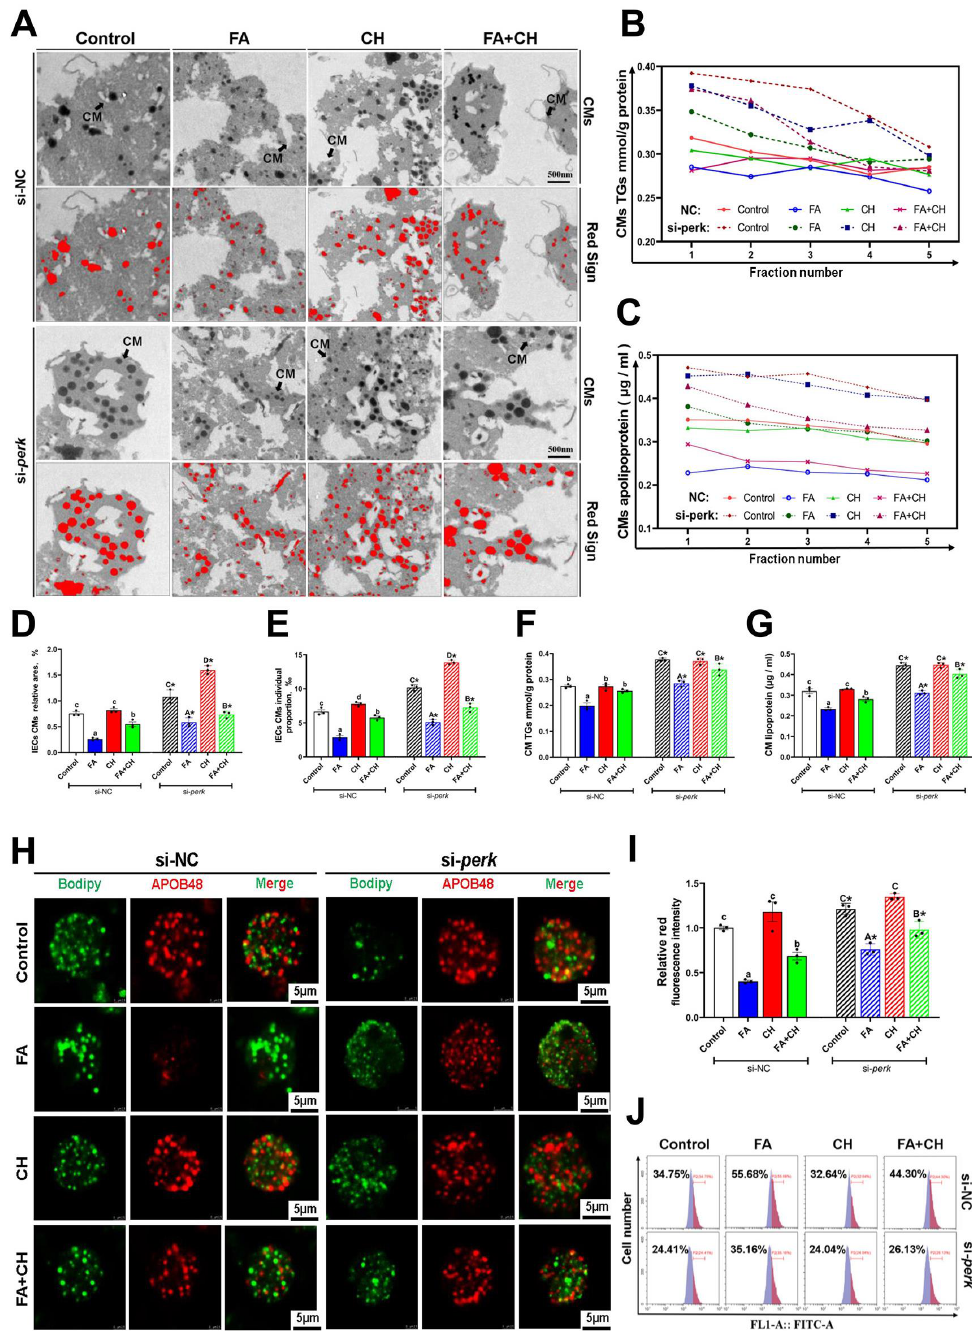
Figure 4. Perk signaling regulated FA/choline-mediated CMs assembly. ( A ) TEM structures of the isolated fractions of IECs’ CMs under FA/choline incubation with si- perk transfection. Scale bar, 500 nm. ( B , C ) Density gradient curve and quantification analysis for CMs-TGs/or apolipoprotein. ( D , E ) Relative CMs areas and individual proportion in TEM structures. ( F , G ) Relative quantification analysis for CMs-TGs/or apolipoprotein. ( H ) The co-localization of Apob48 (red) and LDs (Bodipy 493/503, green) in IECs. Scale bars, 5 µ m. ( I ) Quantitative analysis for relative red intensity of fluorescence in H. ( J ) The presence of LDs with Bodipy 493/503 staining were demonstrated by flow cytometry. Data are mean ± SEM, n = 3 independent biological experiments; different lower-case letters indicate significant differences in si-NC groups; different capital letters indicate significant differences in si- perk groups ( p ≤ 0.05); asterisks indicate significant differences between si-NC and si- perk groups (* p ≤